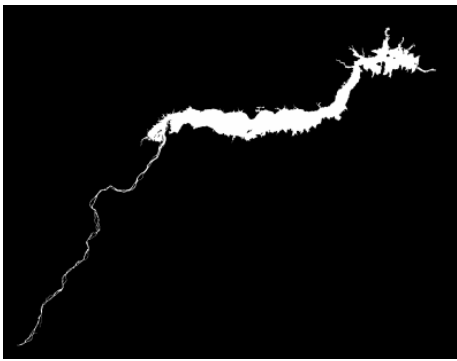
Figure 7: Reservoir detected using the image from June 2015.